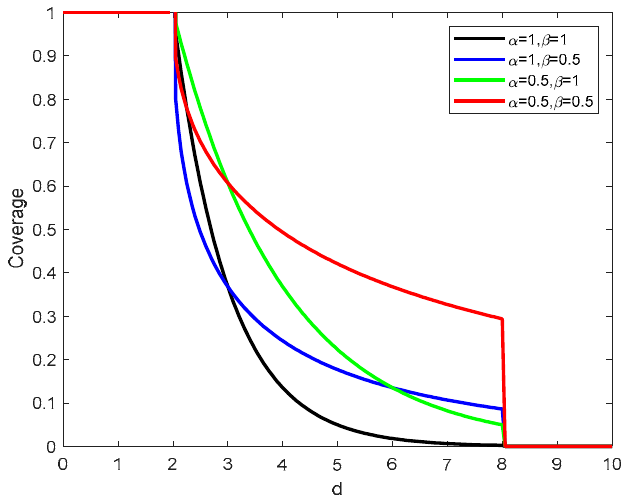
Figure 6. The relationship curve between coverage rate and distance under different attenuation factors.